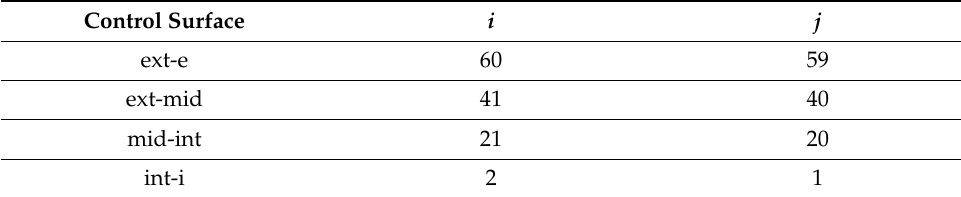
Table 3. Numbers of boundary elements in individual wall layers.